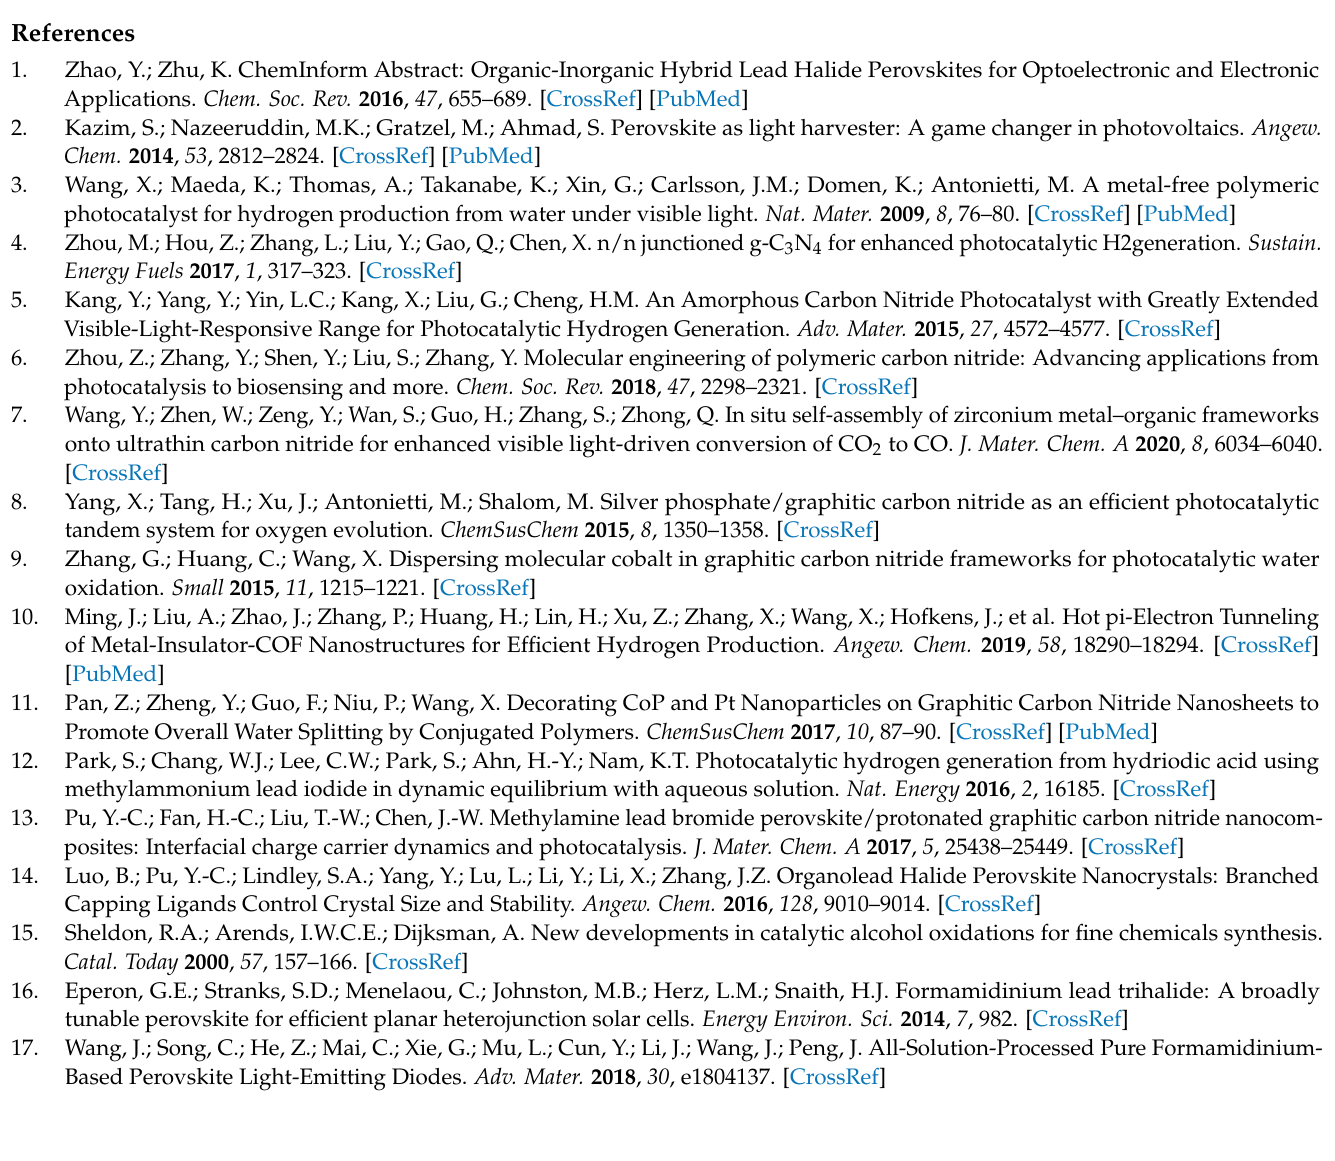
Figure S6. HRTEM of (a) WO 3 nanoplate and (b) WO 3 /FAPbBr 3 hybrids materials. Figure S7. TEM- HAADF image and according elemental mapping of WO 3 /FAPbBr 3 hybrids materials. Figure S8. PXRD of WO 3 /FAPbBr 3 hybrids with different FAPbBr 3 weight ratios, in which # = FAPbBr 3 and * = WO 3 (JCPDS# 43-1035), respectively. Table S1. Photocatalytic oxidation of benzylic alcohol using a series of samples. Table S2. Photocatalytic oxidation of benzylic alcohol using a series of samples with long-pass filter (420 nm, 450 nm and 500